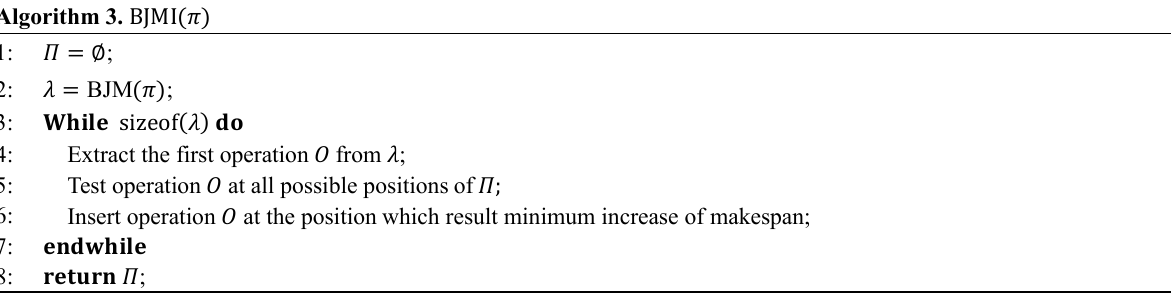
Algorithm 3. BJMI( 𝜋 )